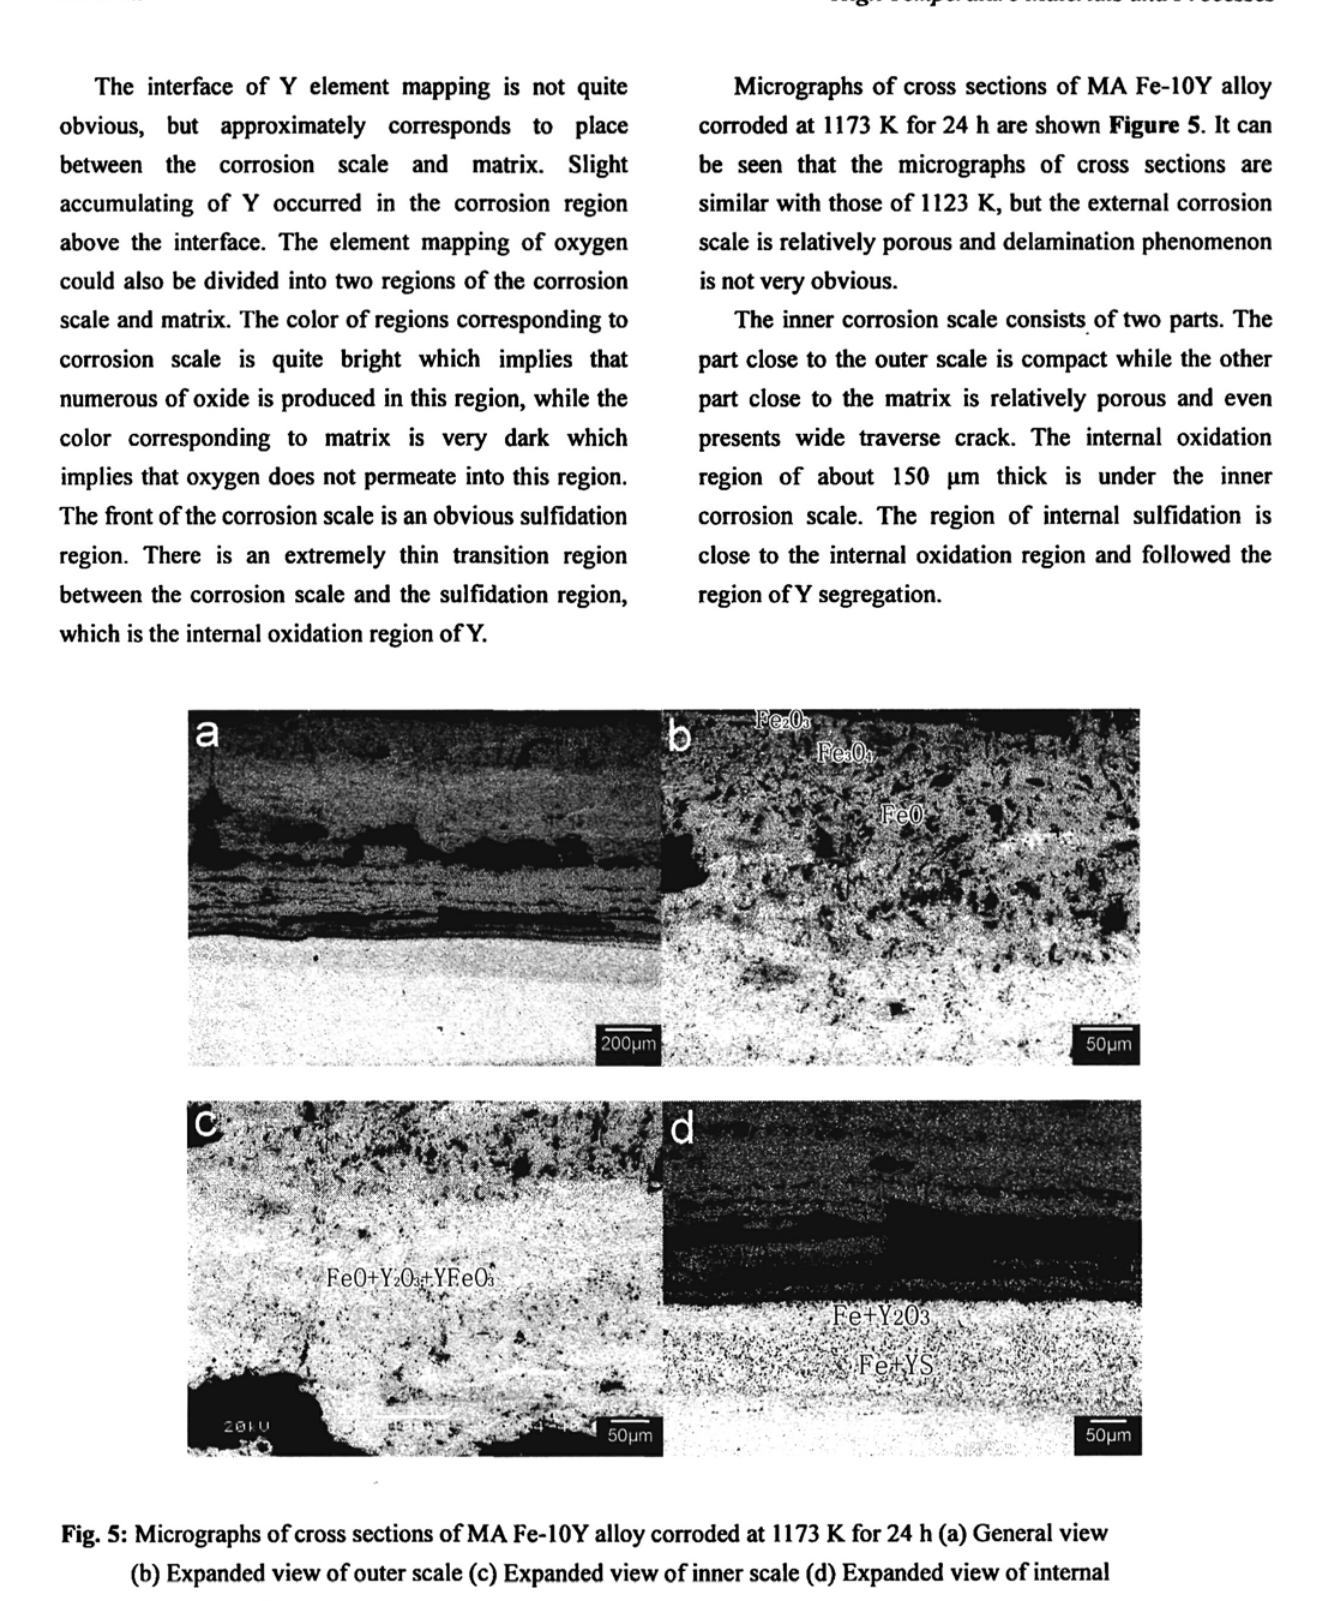
Fig. 5: Micrographs of cross sections of MA Fe-10Y alloy corroded at 1173 Κ for 24 h (a) General view (b) Expanded view of outer scale (c) Expanded view of inner scale (d) Expanded view of internal corrosion